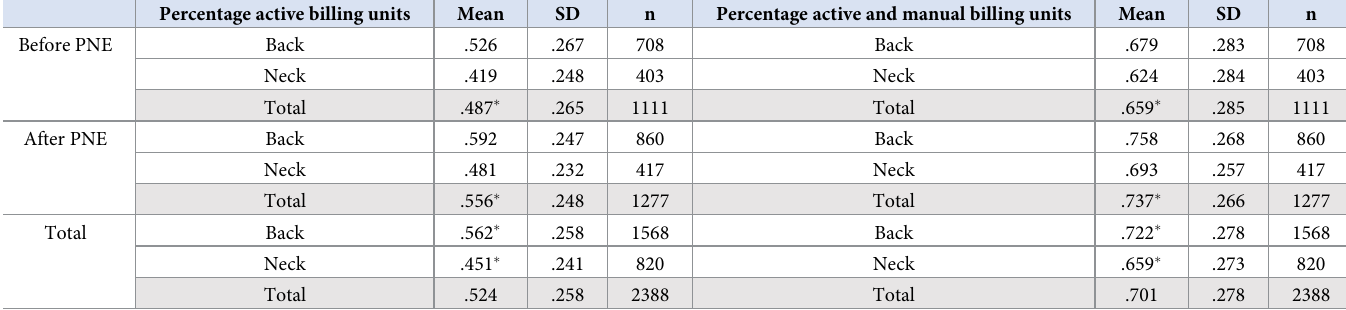
Table 7. Change in percentage of active billing units, and percentage of active and manual billing units per visit for before and after PNE and by body region. Percentage active billing units Mean n